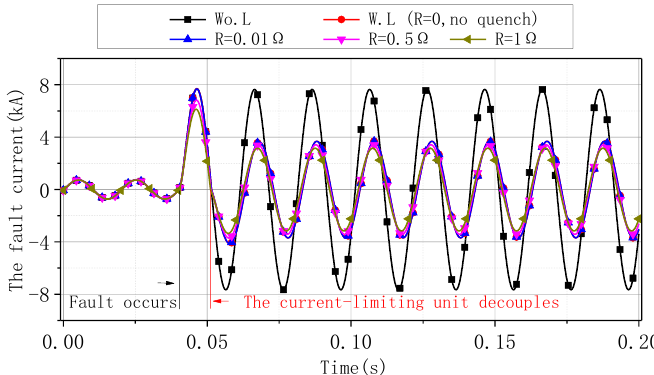
Table 1. Parameters of the simulation model.